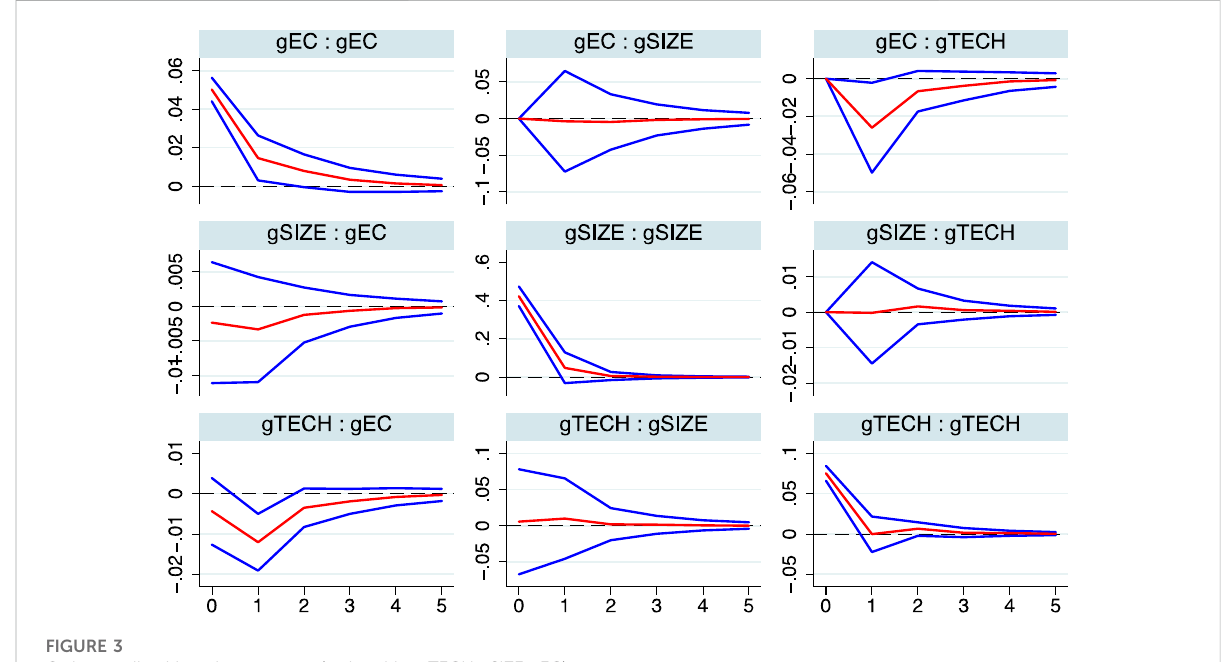
FIGURE 3 Orthogonalized impulse response (ordered by gTECH gSIZE